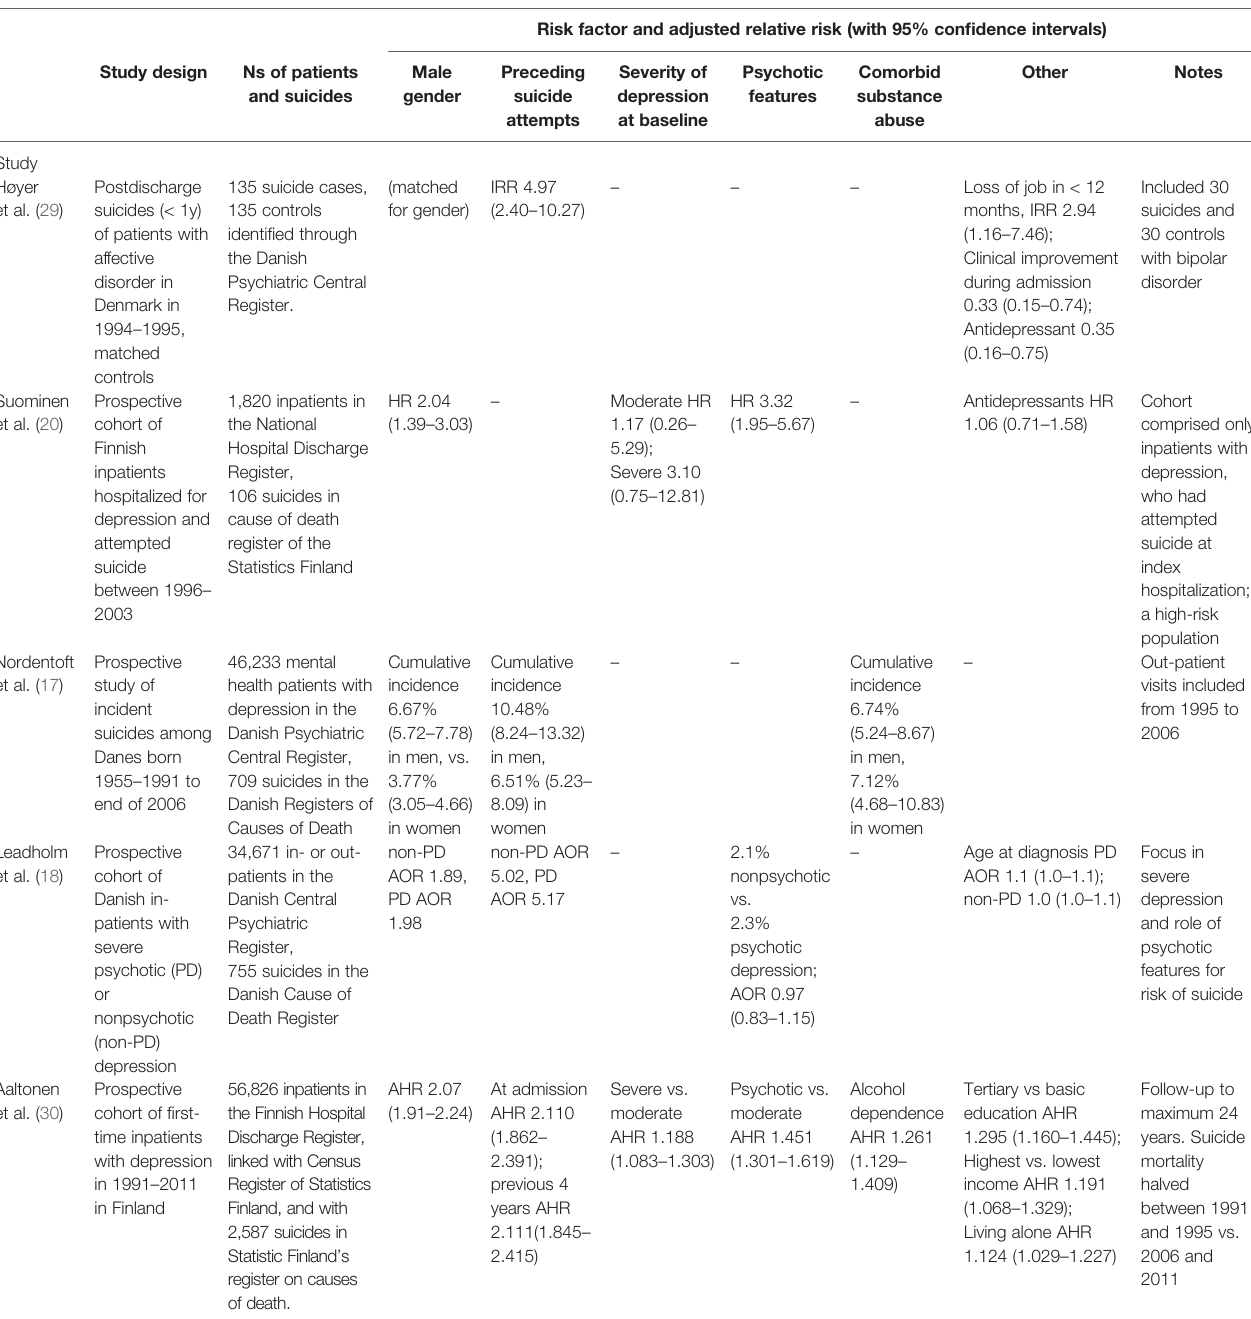
TABLE 3 | Risk factors for suicide in mood disorders in Nordic national-level register-based